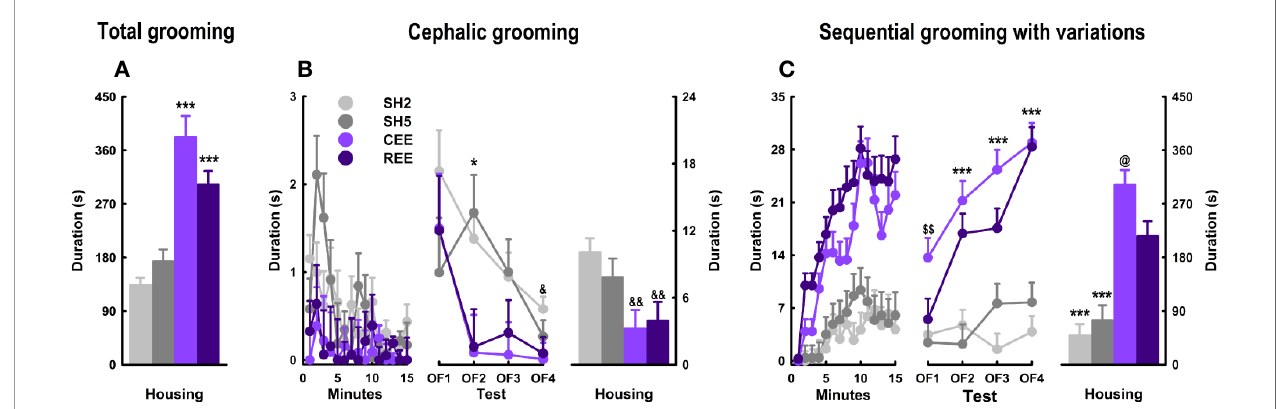
FIGURE 6 | Grooming kinetics and subtypes in the open- fi eld test. Total grooming (A) , cephalic grooming (B) , and sequential grooming with variations (C) over minutes (left panel), days (middle panel), and their cumulative averages (right panel). Data correspond to seconds expressed as mean ± SEM. SH2: Standard housing with two rats. SH5, standard housing with fi ve rats. CEE, continuous environmental enrichment; REE, restricted and unpredictable environmental enrichment. Symbols correspond to single, pairwise-comparisons between groups. CEE and REE vs. SH2 and SH5: * p < .05; *** p < .001. SH2 vs. CEE and REE: & p < .05; && p < .01. CEE vs. REE: @ p < .05. CEE vs. REE, SH2 and SH5: $$ p <